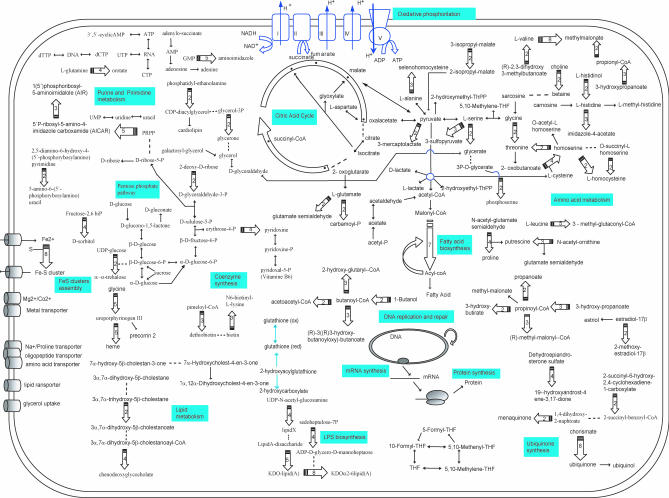
An Overview of Metabolism and Transport in the Proto-MitochondrionMetabolism and transport were deduced from the OGs present in the estimated proteome (see text). Boxes, arrows, and cylinders indicate pathways, enzymes, and transporters, respectively. Several consecutive steps can be condensed into a bigger arrow with a number indicating the steps included. Single missing steps connecting recovered pathways are indicated as dashed lines.